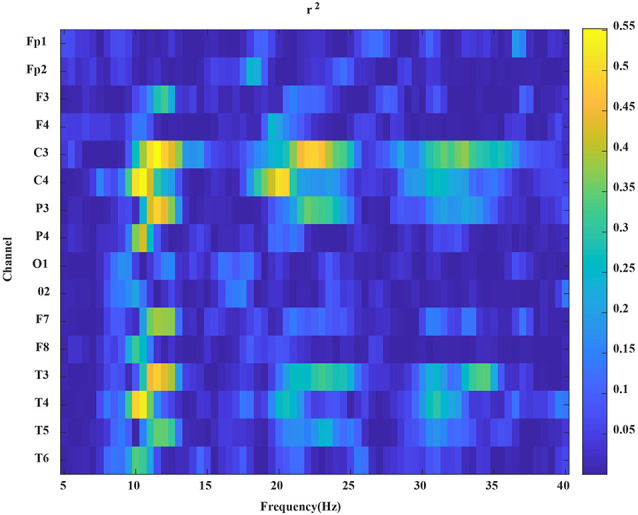
An example of the r2 map. The x-axis represents the frequency, the y-axis represents the channels.